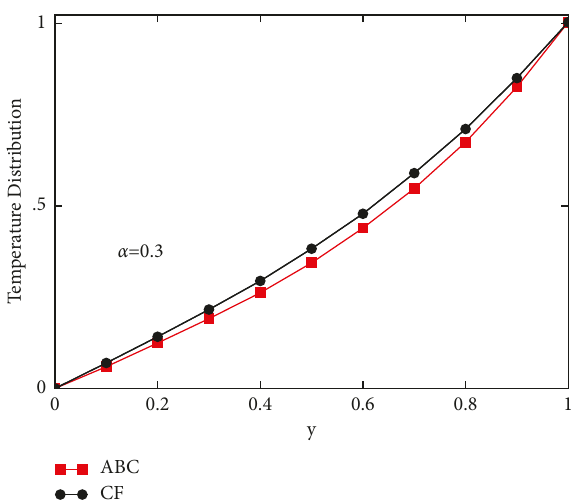
Figure 5: Correlation between the temperatures through CF [37] and ABC, Pr